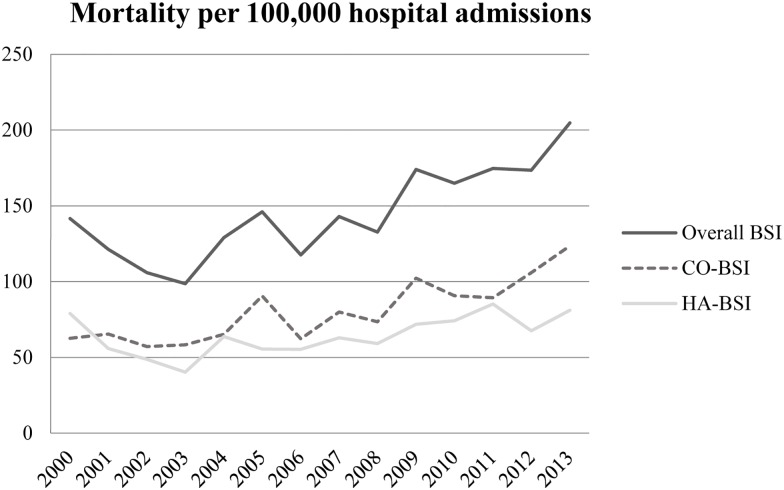
Mortality per 100,000 hospital admissions.